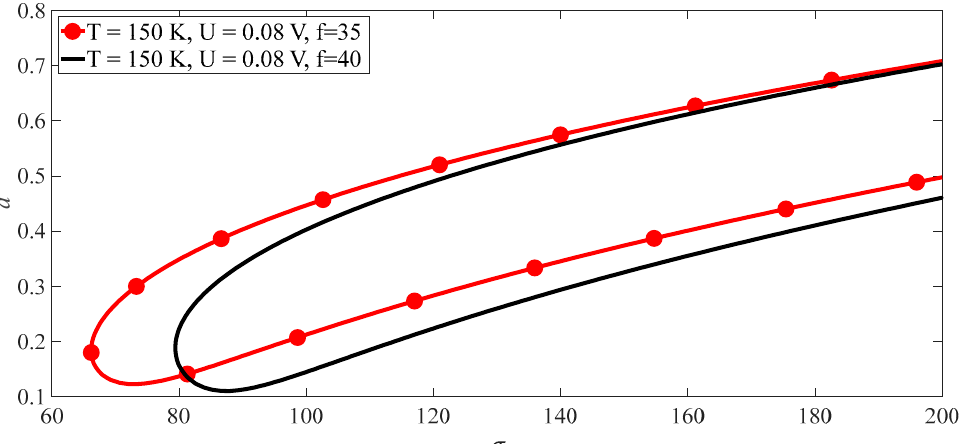
= 5 c . 1 = 5 c . = 1 5 c . 1